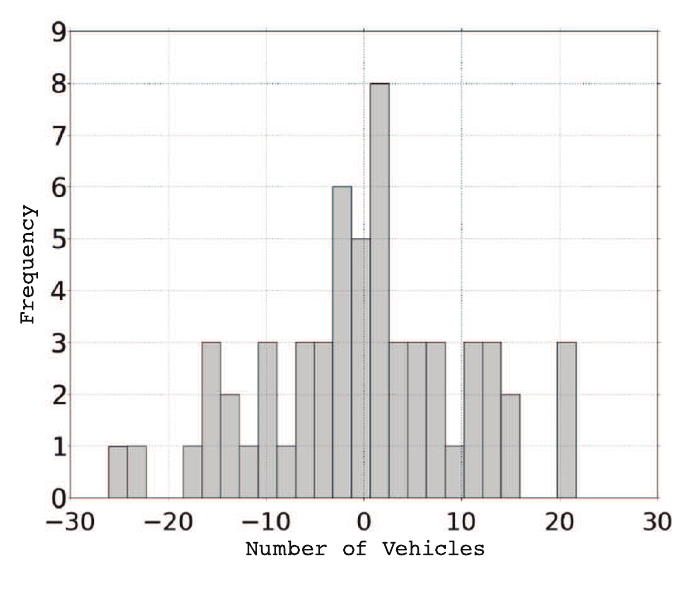
Figure 7. Absolute error